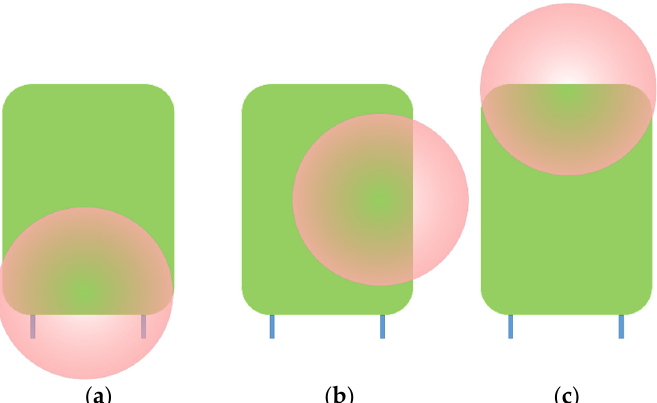
Figure 3. Possible misalignment of LiDAR d FOV with the target ( a ) uphill, ( b ) left curved, and ( c ) downhill.